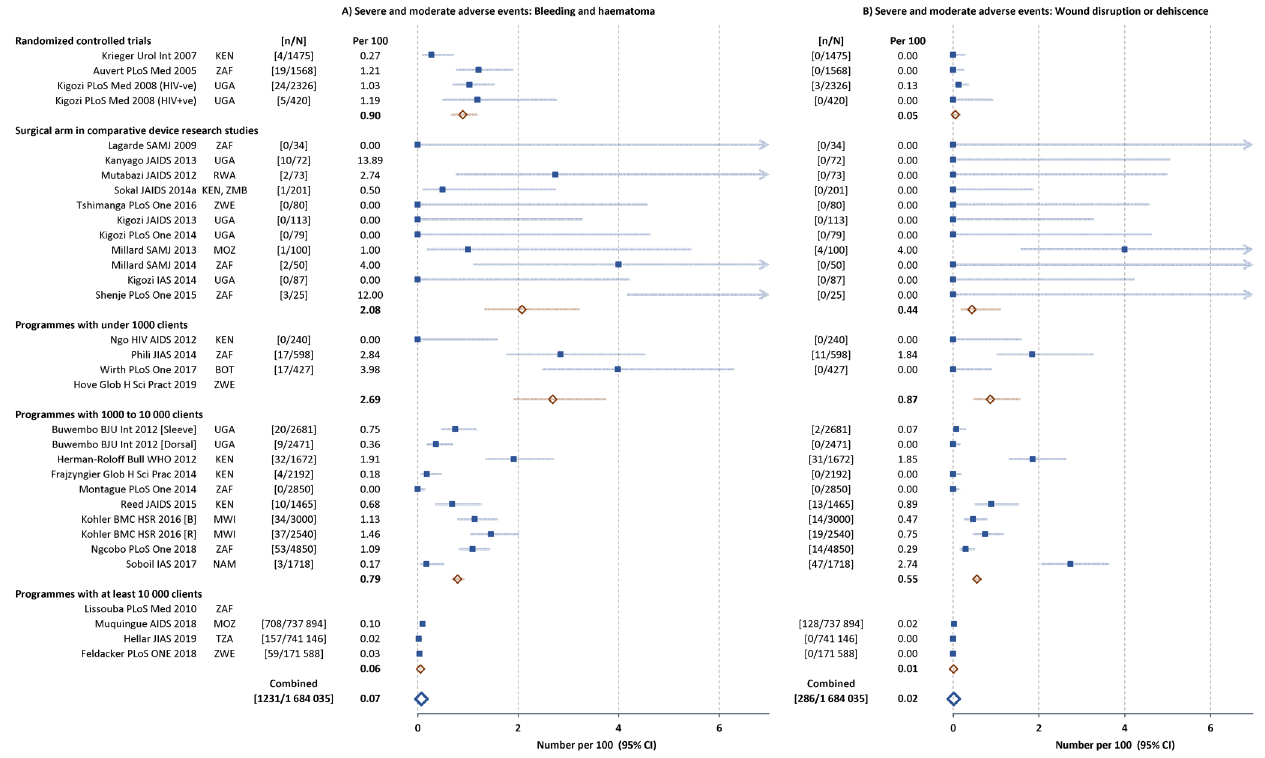
Figure 4. Severe and moderate bleeding- ( A ) and wound-related ( B ) adverse events (AEs) in individual studies. Filled squares individual cohorts, open red lozenge all cohorts in subgroup, large open blue lozenge all cohorts combined, lines 95% confidence intervals (truncated line indicated by